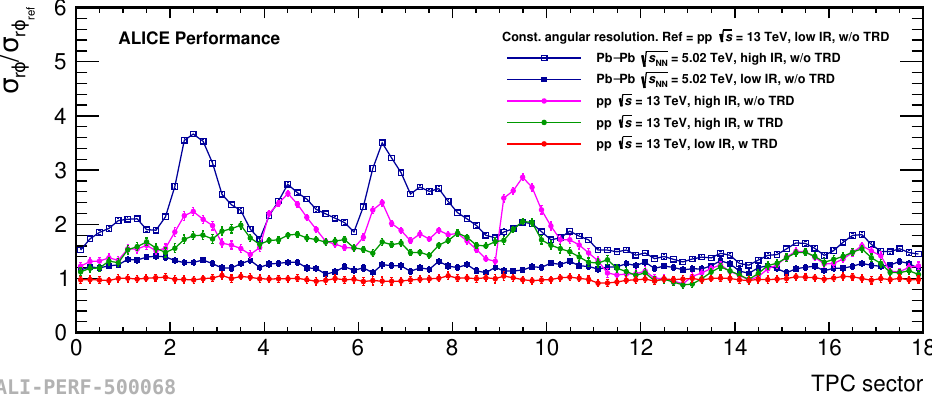
Figure 14. The angular match between the vertex constrained TPC tracks and the ITS tracks at the primary vertex as a function of the number of TPC sector, which corresponds to a 20-degree wide azimuthal region as an approximation of the degradation of the combined tracking resolution. The data are normalized to the low interaction rate data with negligible space charge distortion fluctuations. In the sector regions 2–9 with larger distortions (see Figure 9), the angular agreement is much broader. The degradation was strongly attenuated by using the TRD in the track